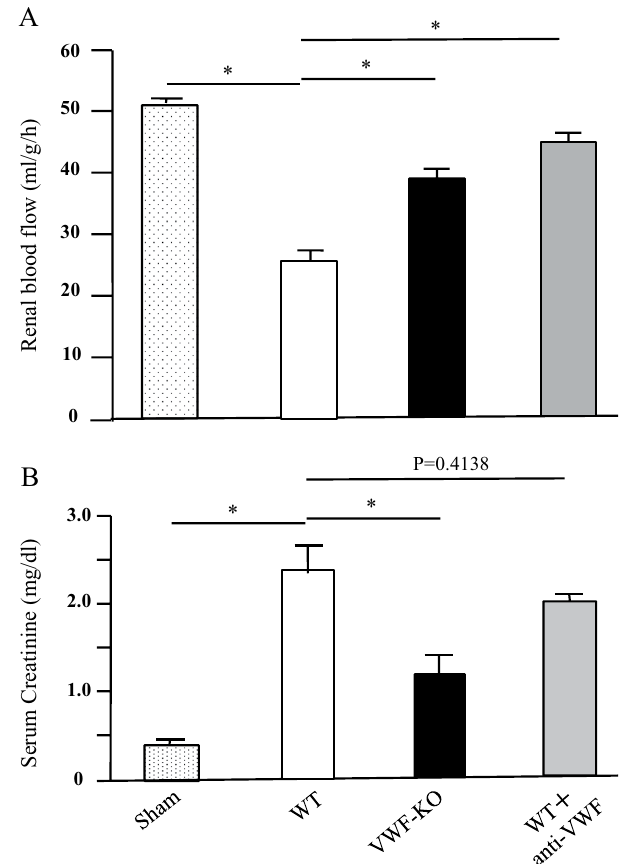
Figure 4. Effects of the function-blocking anti-VWF antibody NMC4 on RBF and serum creatinine in mice with I/R kidney injury. Experimental conditions were basically the same as those described in the Fig. 1 legend, except that the anti-VWF antibody NMC4 (10 μ g/mouse) was injected intravenously instead of rADAMTS13. ( A ) Each bar indicates the mean actual RBF unit ± SEM (ml/g/h, n = 10, each group) at 24 h after reperfusion. Note that anti-VWF antibody significantly ( * ) improves the restoration of RBF in WT mice. ( B ) Bars indicate the mean ± SEM of serum creatinine values (n = 10, each group) at 24 h after reperfusion. The serum creatinine value in WT mice is also improved by antibody injection, although the difference is not statistically significant. These findings indicate the beneficial effects of the function-blocking anti-VWF antibody following mouse I/R kidney